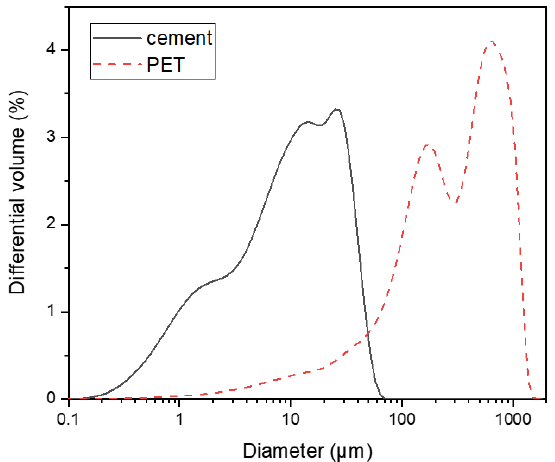
Figure 2. Particle size distributions of the cement and PET powder.